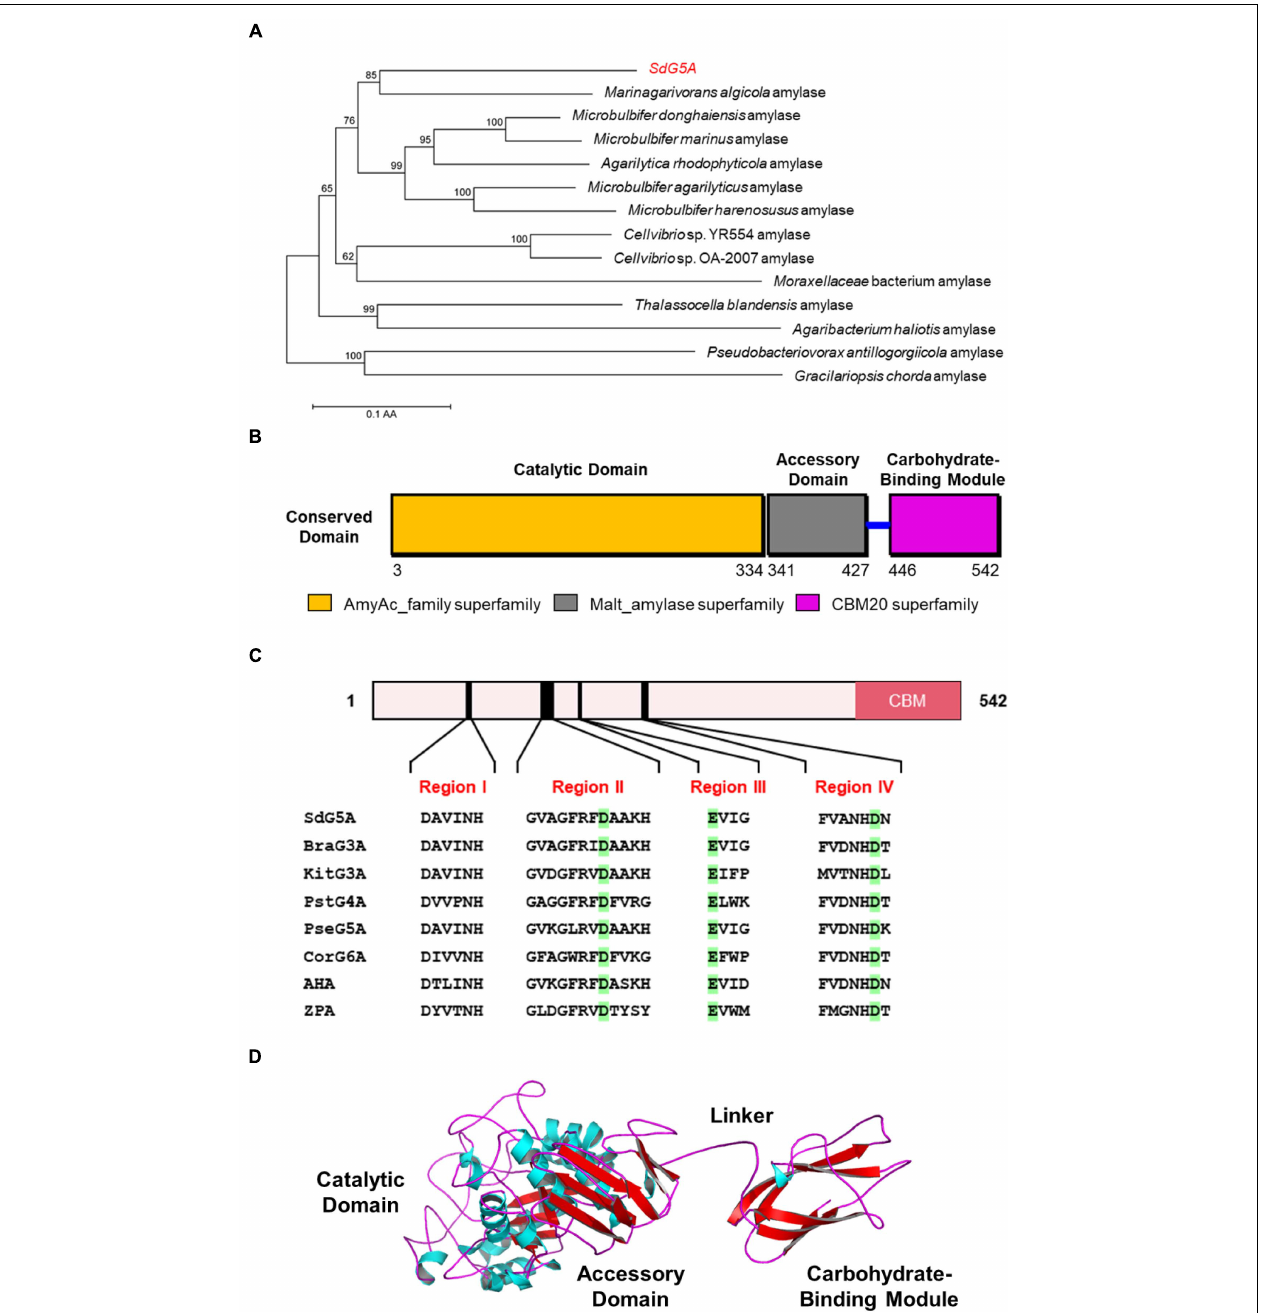
FIGURE 4 | Sequence and three-dimensional structure analysis of SdG5A. (A) Phylogenetic tree of the amino acid sequences of SdG5A. The tree was constructed using the neighbor-joining algorithm of the MEGA program (version 5.0). Bootstrap values ( n = 1,000 replicates) are reported as percentages. The scale bar represents the number of changes per amino acid position. (B) Analysis of the conserved domains identified by Conserved Domain Database (Marchler-Bauer et al., 2017). (C) Conserved regions I–IV of α -amylases. Amino acid residues corresponding to catalysis are highlighted in green. (D) Template-based predicted structure model of